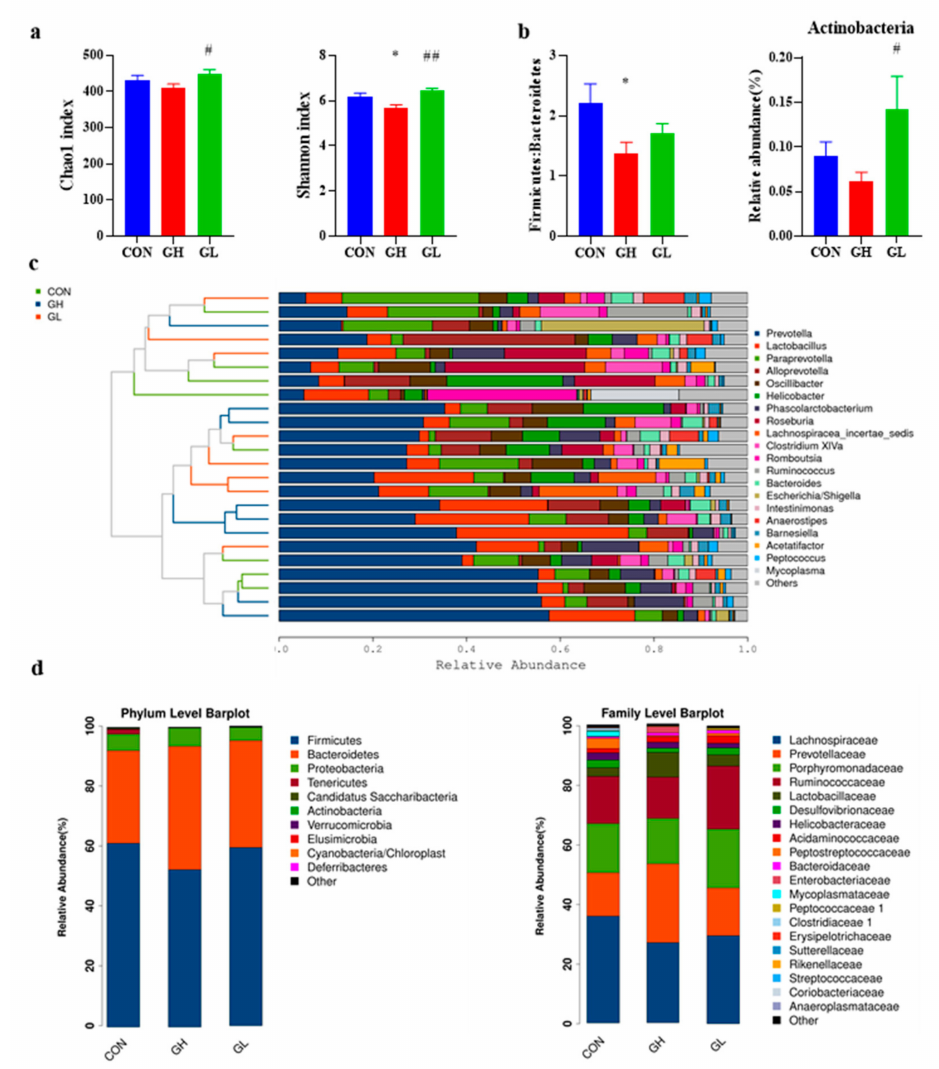
Figure 10. Species diversity and composition of gut microbiota. ( a ) Chao1 and Shannon index describing microbial α diversity. ( b ) Firmicutes : Bacteroidetes ratio and the relative abundance of Actinobacteria . ( c ) Cluster analysis of species at genus level. ( d ) Bar chart of relative abundance of species at phylum and family levels. * significant differences vs. CON group, p < 0.05. # significant differences vs. GH group, p < 0.05. ## significant differences vs. GH group, p <